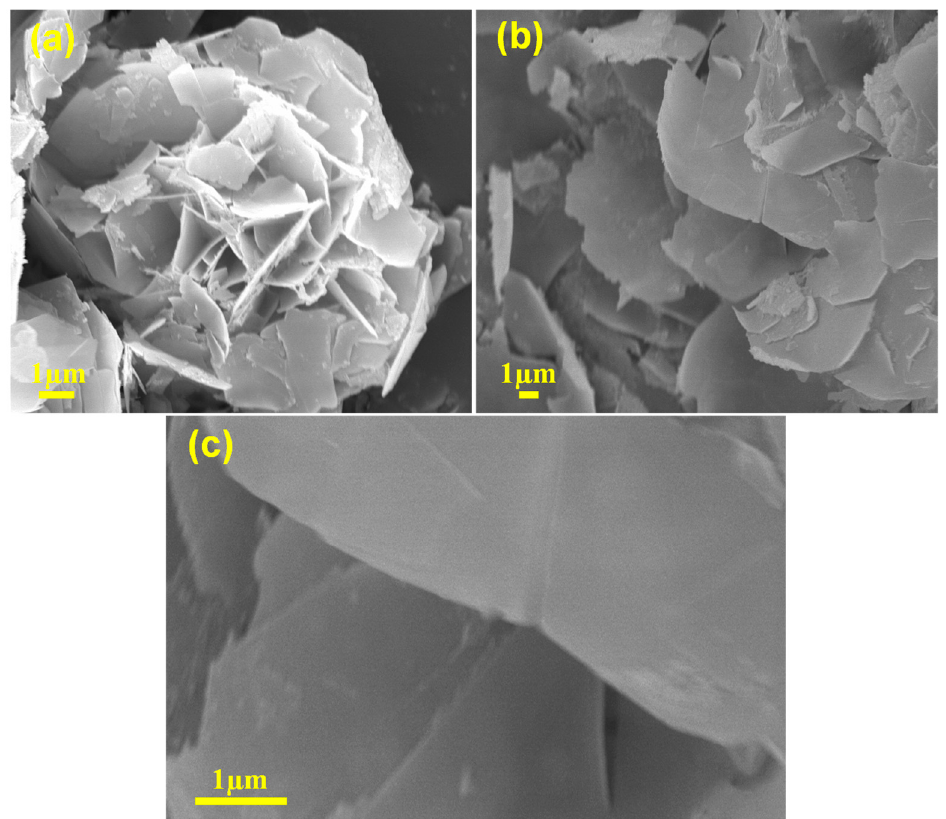
Figure 1. SEM images of CSHDS: ( a ) First location, ( b ) second location, and ( c ) after magnification ×10,000.